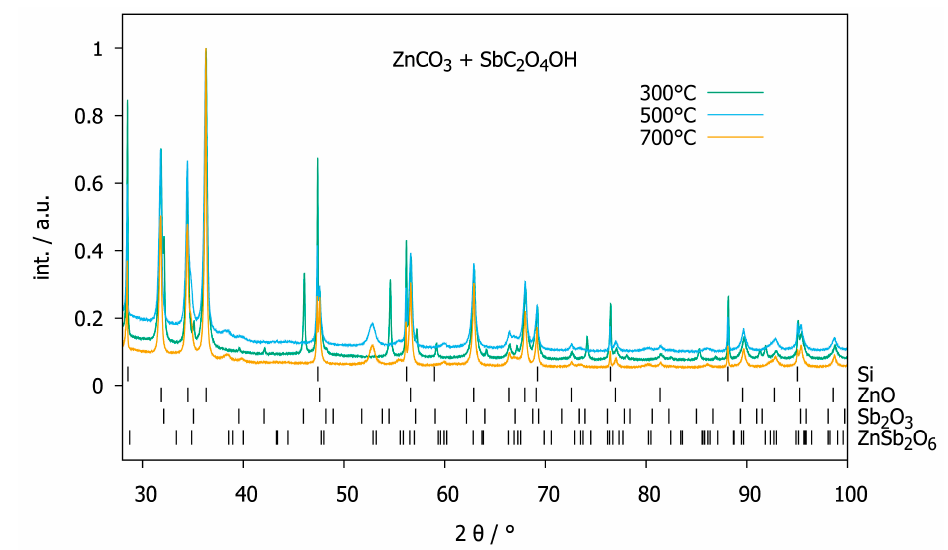
Figure 6. XRPD patterns (normalized intensities, Huber G670 diffractometer, CuK α 1 radiation, internal standard silicon powder) of a mixture of ZnO and SbC 2 O 4 OH with a 10:1 molar ratio after heat treatment at 573 K (green), 773 K (blue) and 973 K (orange), respectively.